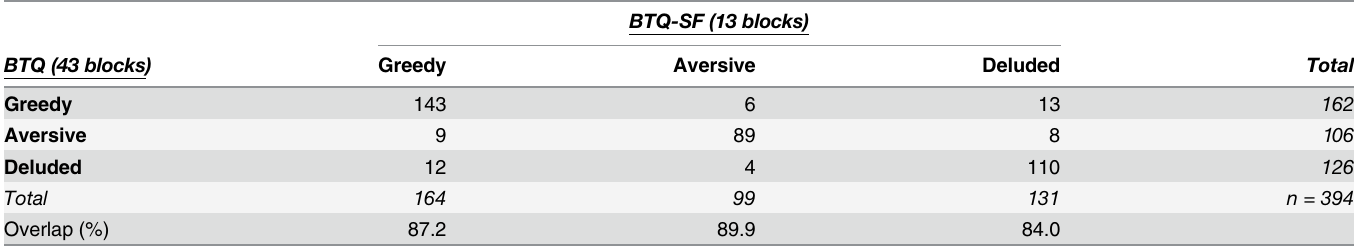
Table 7. Classification of participants from sample 1 based on the BTQ (43 blocks) and the BTQ-SF (13 blocks). BTQ-SF (13 blocks) BTQ (43 blocks) Greedy